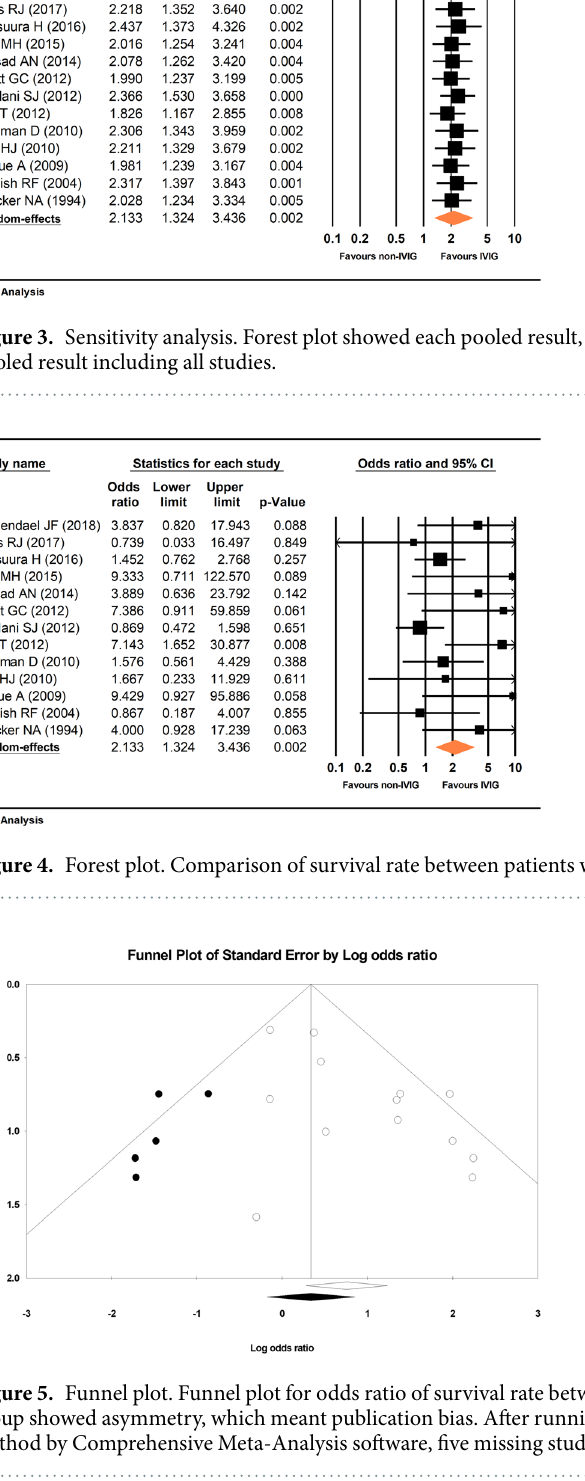
implying that the heterogeneity of the studies was moderate. The strength of pooled estimate did not significantly differ according to the characteristics of individual studies in the leave-one-out sensitivity analysis (Fig. 3). In con- sideration of moderate heterogeneity, the meta-analysis was performed using a random-effects model.